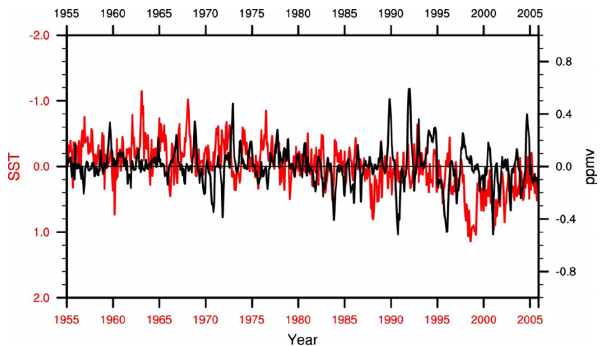
Figure 14. The difference in southern high-latitude lower- stratospheric ozone variations between T1 and ((T2 + T3) / 2) (black line), and SST variations in the marginal seas of East Asia (5 ◦ S– 35 ◦ N, 100–140 ◦ E) based on the HadISST data (red line). The sea- sonal cycle is removed from two time